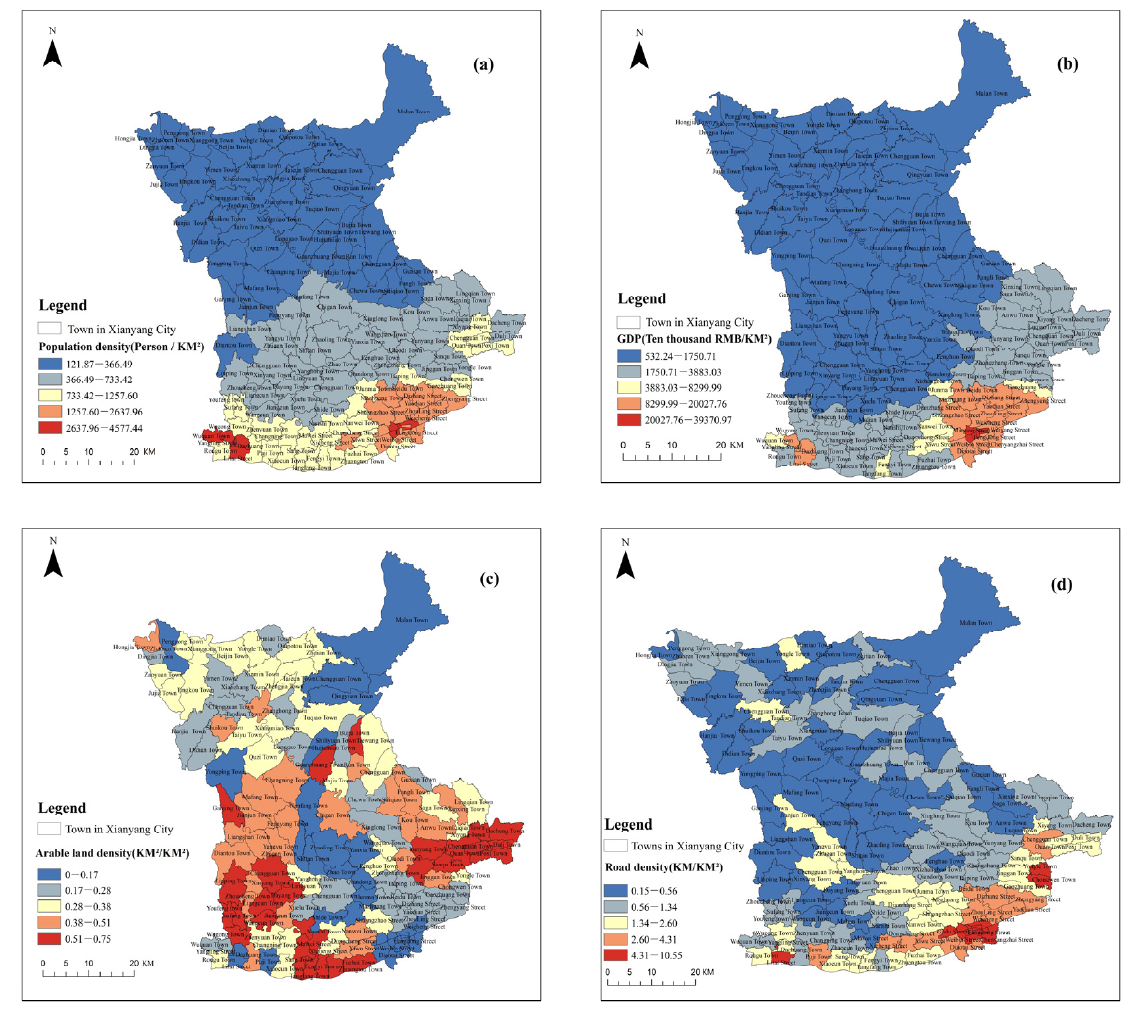
Figure 4. Landslide vulnerability assessment factors: ( a ) population density; ( b ) GDP density; ( c ) arable land density; ( d ) road density.